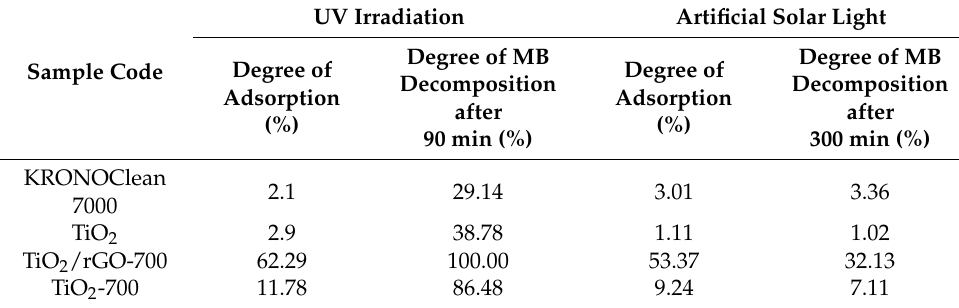
Figure 10. Degree of methylene blue decomposition under ( a ) UV light and ( b ) artificial solar light. Table 4. Degree of methylene blue adsorption and